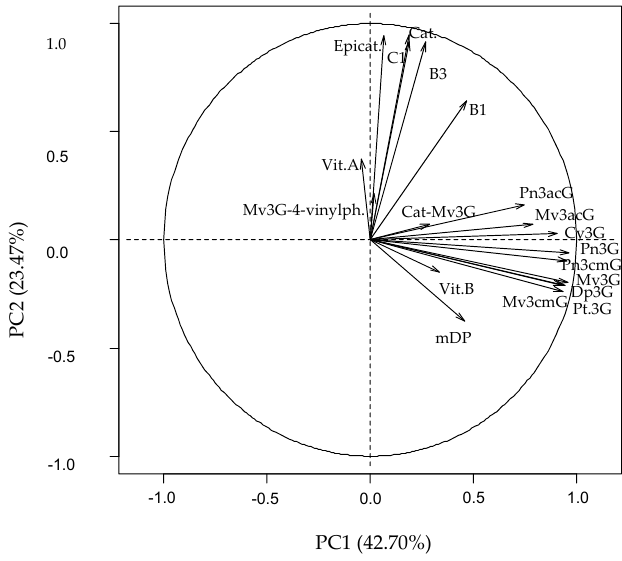
Figure 3. Principal component (PC) analysis. Distribution of samples along PC1 and PC2 and component weights of 19 variables. Mv3G-4-vinylph., pyranomalvidin-3- O -glucoside-4-vinylphenol; Vit.A, Vitisin A; Epicat., Epicatechin; C1, procyanidin trimer C1; Cat., Catechin; B3, procyanidin dimer B3; B1, procyanidin dimer B1; Cat-Mv3G, direct adduct catechin-malvidin-3- O -glucoside; Pn3acG, paeonidin-3- O -acetylglucoside; Mv3acG, malvidin-3- O -acetylglucoside; Cy3G,